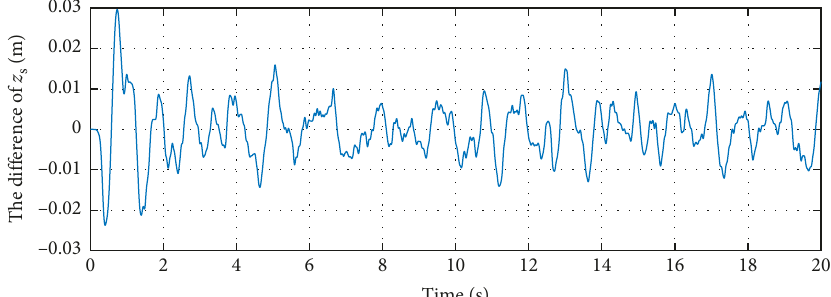
Figure 6: The difference of z